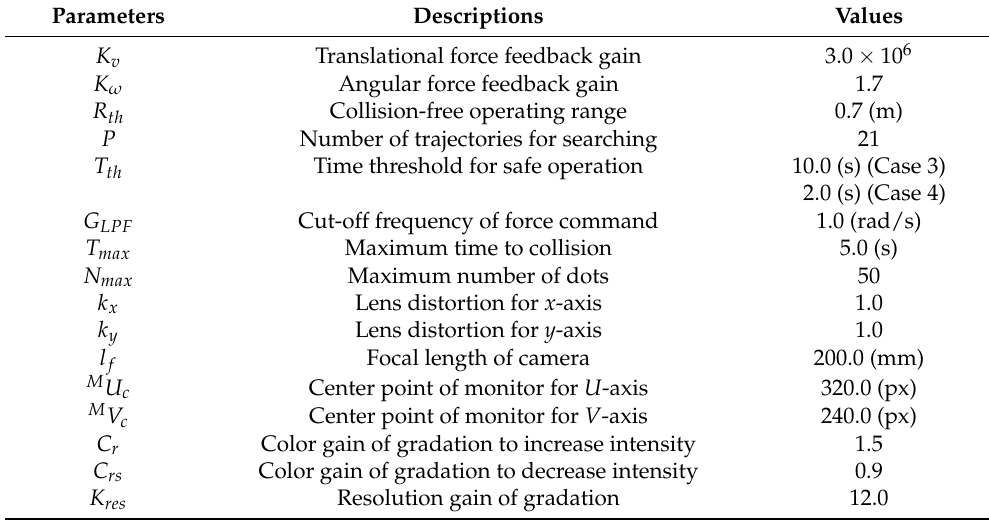
Table 2. Control